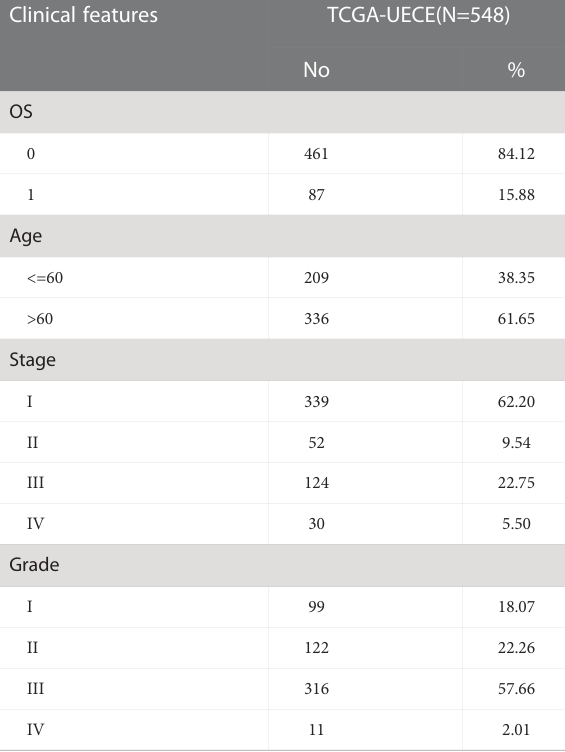
TABLE 2 Clinical information of Uterine Corpus Endometrial Carcinoma cohort. Clinical